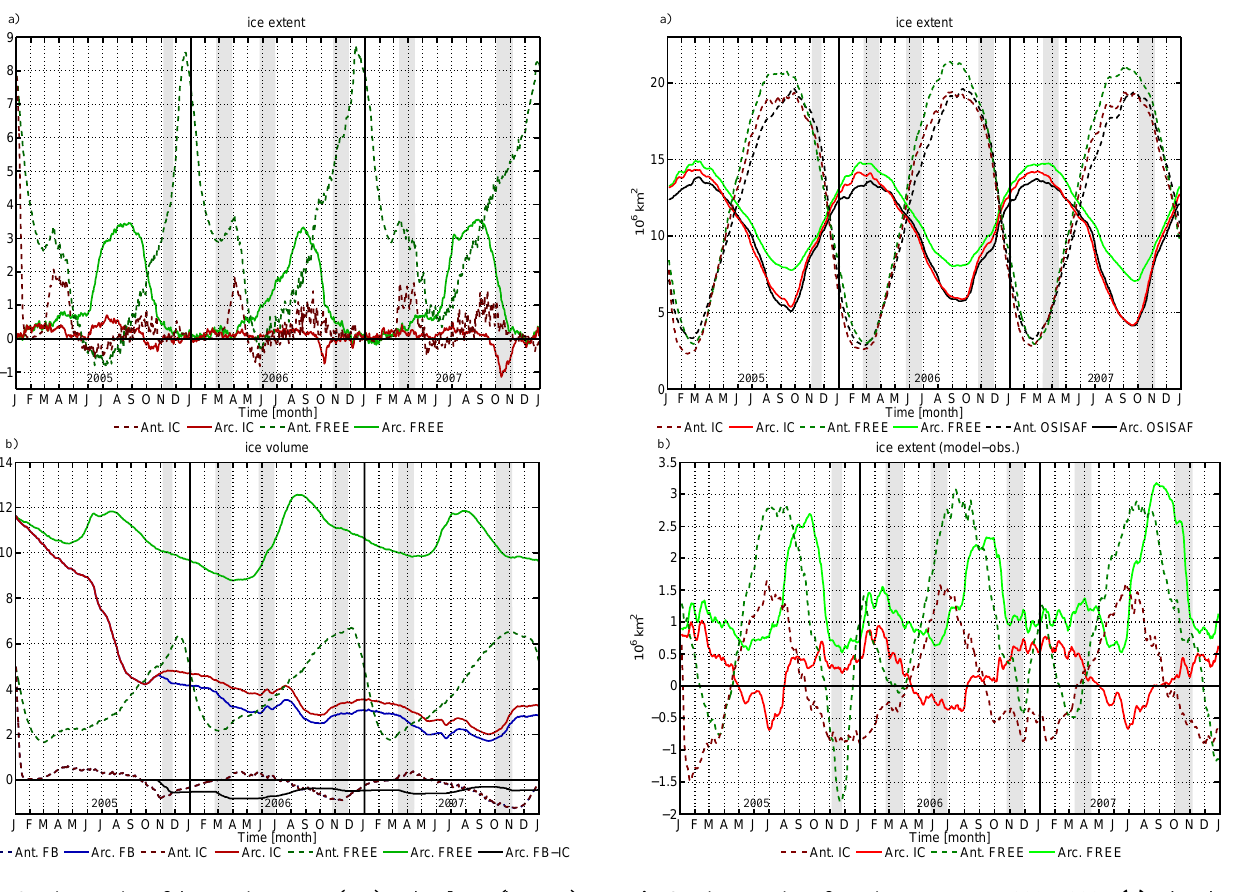
Fig. 2. Time series of the sea-ice extent (top) and volume (bottom) difference compared to synthetic observations for both the NH (full lines) and the SH (dashed lines) over 2005–2007. Green lines rep- resent the FREE run difference, red lines the IC run difference, blue lines the FB run difference and black line the FB-IC difference. Grey shading areas indicate periods when the ice freeboard data are available.